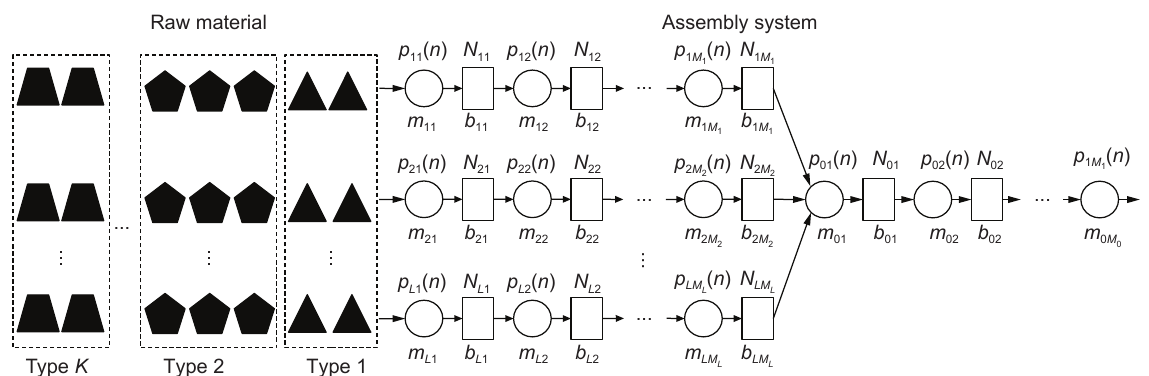
Fig. 1 Batch-based assembly system with Bernoulli